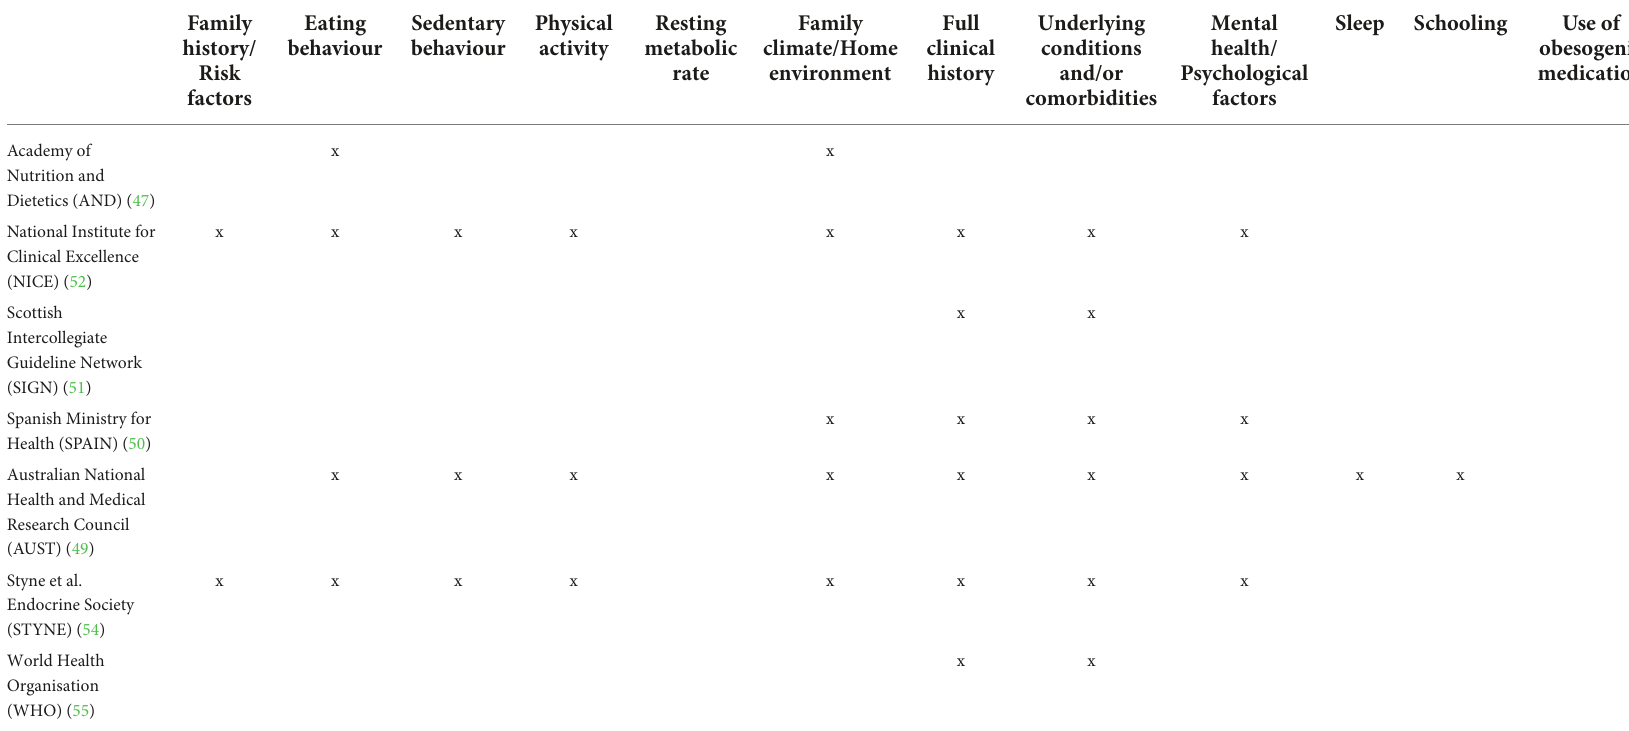
TABLE 3 Summary of specified assessment categories in guideline recommendations.